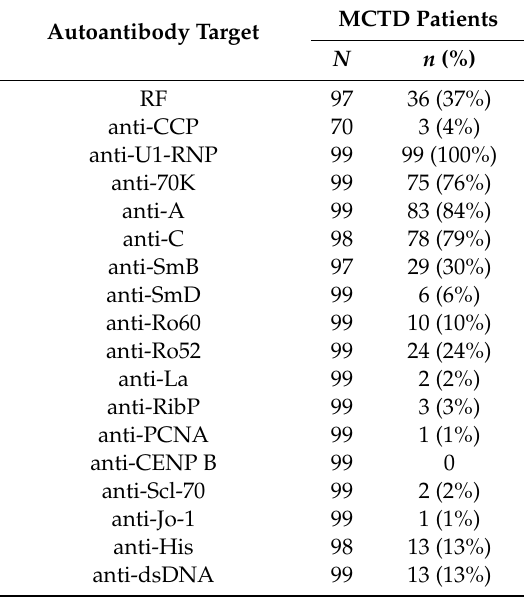
Table 2. Autoantibody profile in the mixed connective tissue disease (MCTD)